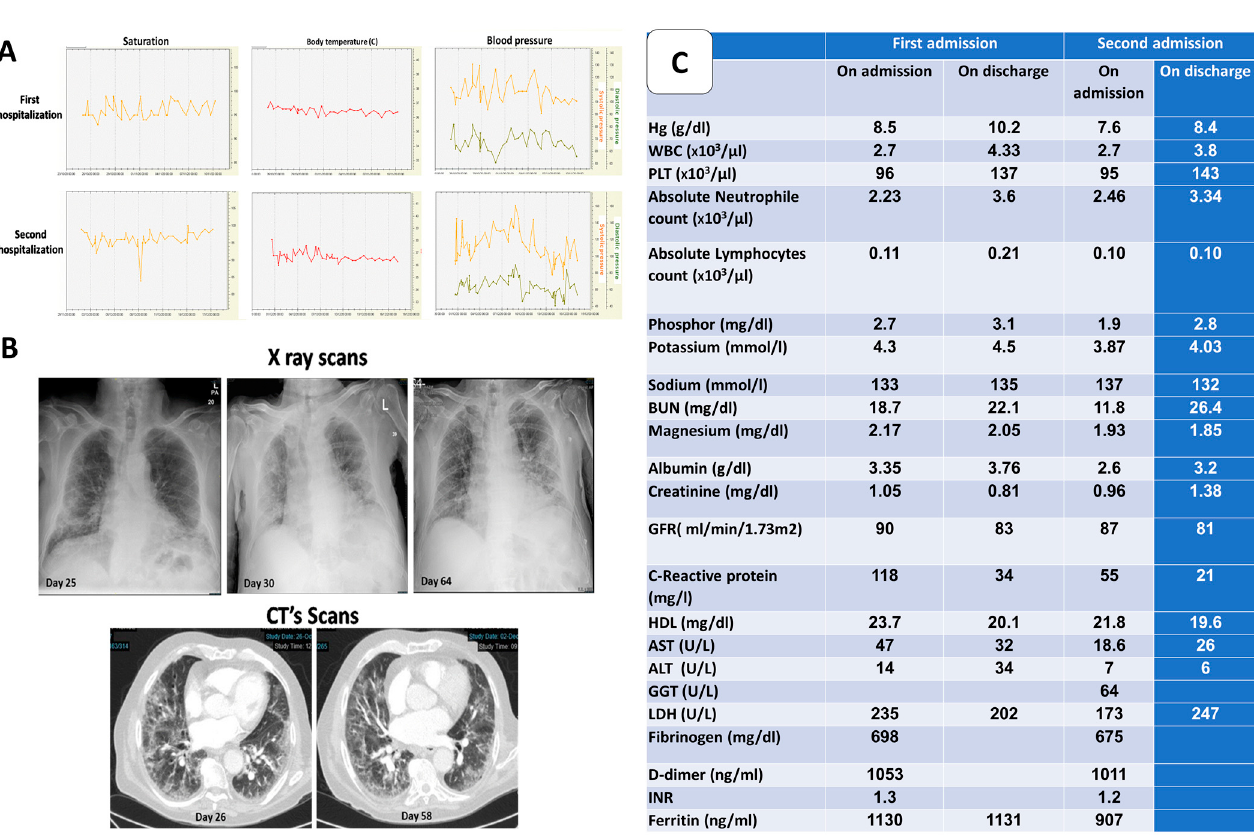
Figure 1. ( A ) O 2 saturation, body temperature, systolic and diastolic blood pressure. The upper and lower panels relate to the first and the second hospitalization, respectively. ( B ) Upper panel: Posterior anterior chest radiograph showing bilateral patchy lung consolidation in a peripheral distribution pattern on days 25, 30 and 64 after the first positive corona test. Lower panel: Unenhanced, thin-section CT performed on day 26 after the first positive corona test showing bilateral ground–glass attenuations with subsequent deterioration in the second hospitalization on day 58. ( C ) Complete blood count and bio-chemical results of the patient during the first and the second hospitalizations upon admittance and discharge.